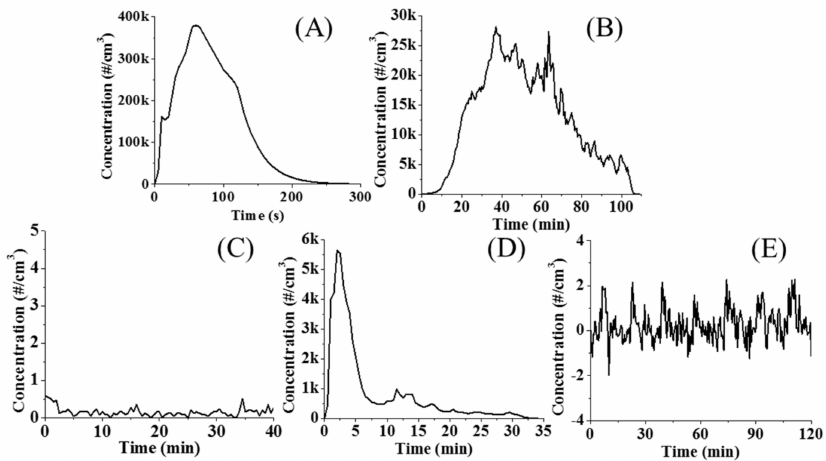
Figure 8. Concentrations of aerosol particles emitted from the synthesis of making 1 mg Si NTs,